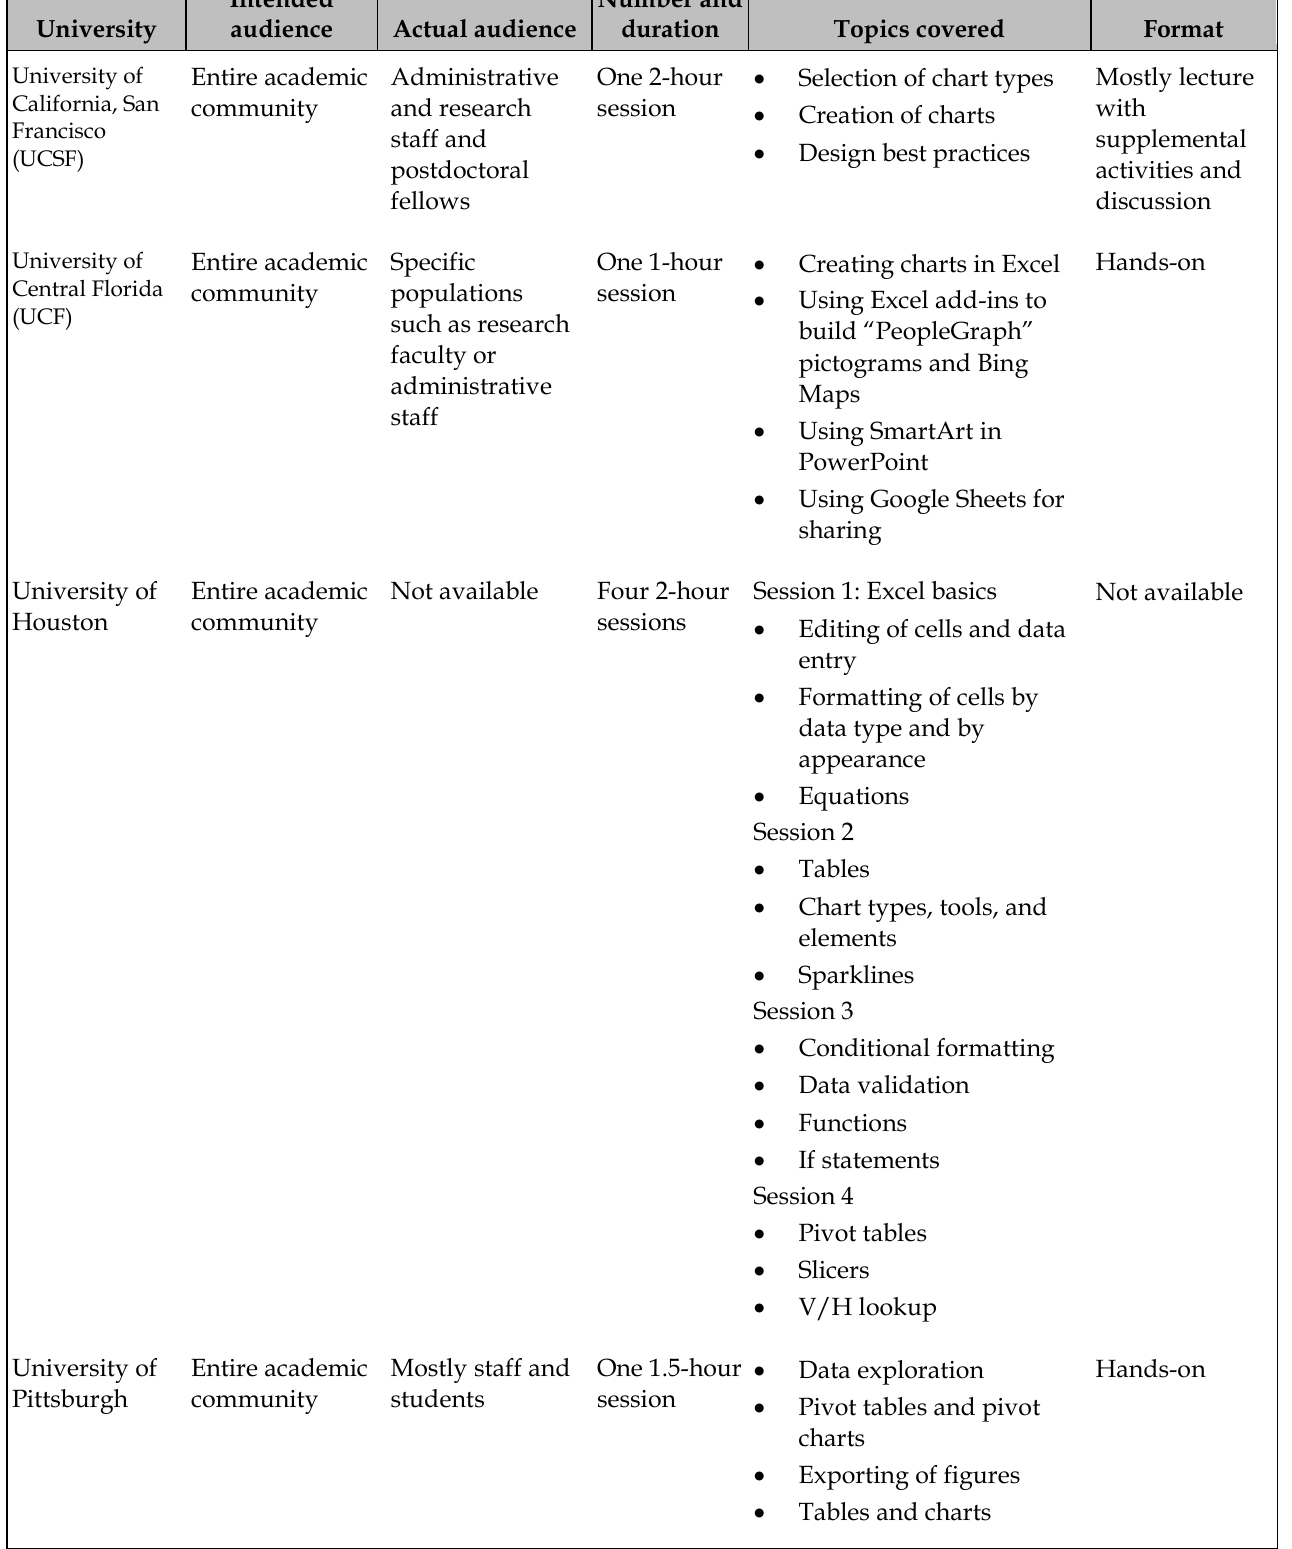
Table 1 Description of Excel-focused data visualization workshops offered by eight institutions